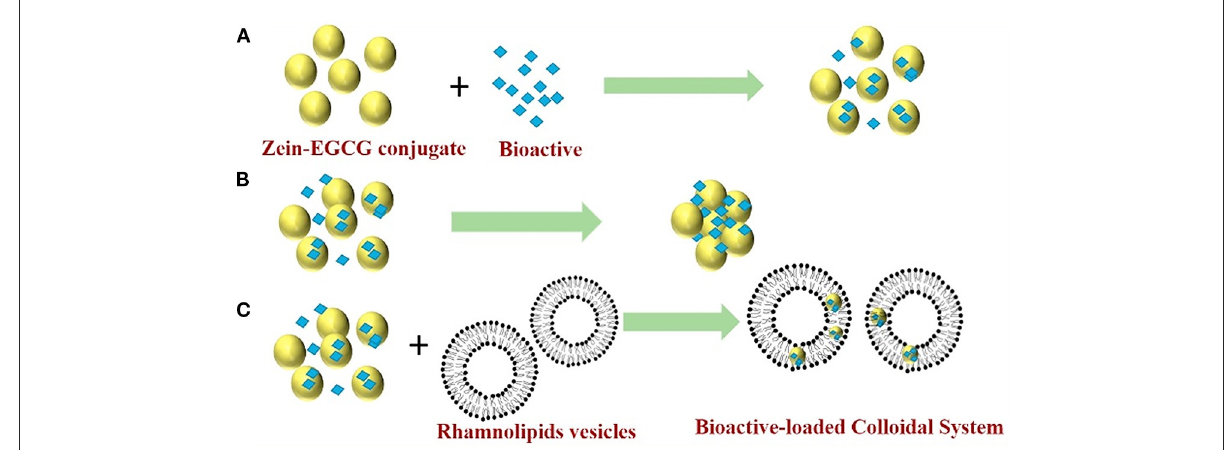
FIGURE6 Proposed mechanisms for a mixed colloidal delivery system consisting of zein-EGCG conjugate nanoparticles and rhamnolipids vesicles. Zein-EGCG conjugate interacts with bioactive and self-assembles to form nanoparticles that embedded bioactive inside by antisolvent (A) ; In the absence of surfactant, the nanoparticles aggregate due to hydrophobic interactions of zein in water solution (B) ; In the presence of rhamnolipids vesicles, the nanoparticles do not aggregate because the coating of surfactant reduces hydrophobic interactions and increases the electrostatic and steric effects between nanoparticles (C) . Reprinted from ( 102) with permission from Elsevier.